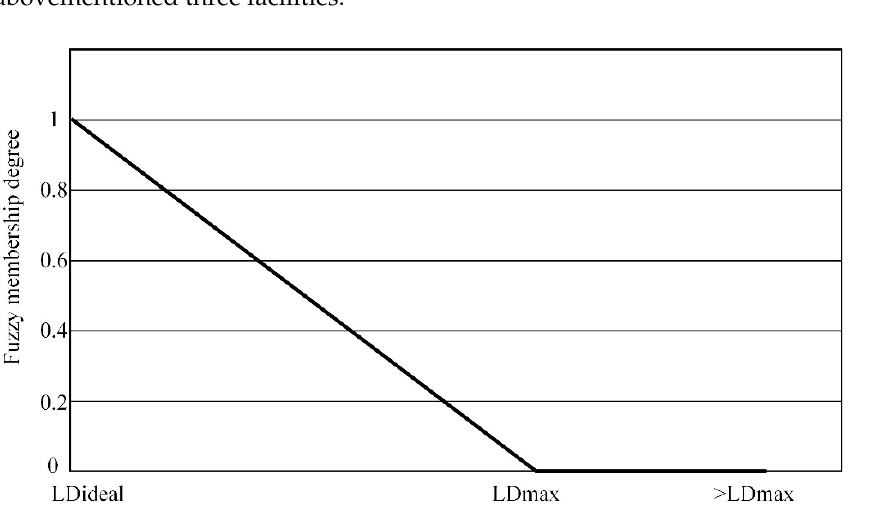
Figure 2. Fuzzy membership function of lost working days.